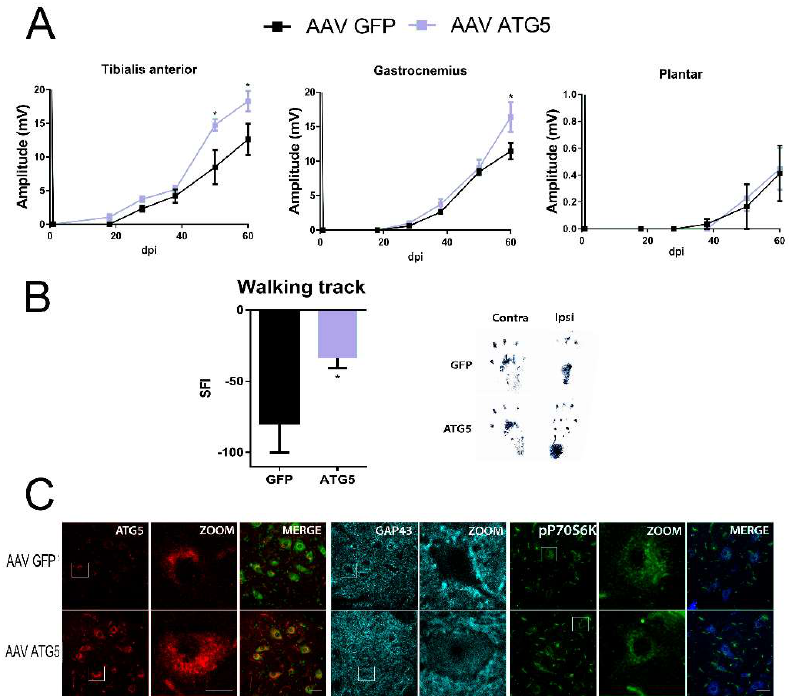
Figure 1. ATG5 overexpression increases motor axon regeneration. ( A ) Mean amplitudes ( ± SEM) values of compound muscle action potential (CMAP) recordings obtained during follow-up post-axotomy from tibialis anterior, gastrocnemius, and plantar muscles in animals overexpressing GFP or ATG5 (n = 4–5, ANOVA, post hoc Bonferroni, * p < 0.05 vs. AAV-GFP). ( B ) Left , Graph of the sciatic functional index (SFI) obtained with the walking track analysis of the sciatic nerve in injured animals overexpressing ATG5 or GFP ( t -test, * p < 0.05 vs. AAV-GFP). Right , representative footprints from ipsi- and contra-lateral paws at 60 days post-injury (dpi). ( C ) Representative confocal images of infected motoneurons (MNs) with either AAVrh10-GFP or AAVrh10-ATG5, immunolabeled for ATG5, GAP-43, and phospho-p70S6K at T-389, counterstained with FluoroNissl Green (left panels) or FluoroNissl Blue (right panels) and merged images at 60 dpi after nerve axotomy. Scale bar = 50 µ m and 25 µ m for